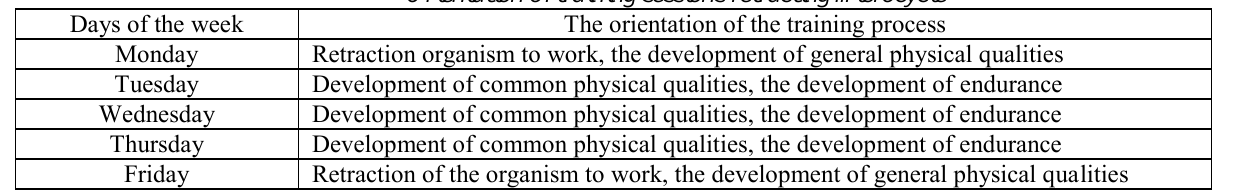
Orientation of training sessions retracting microcycle The orientation of the training